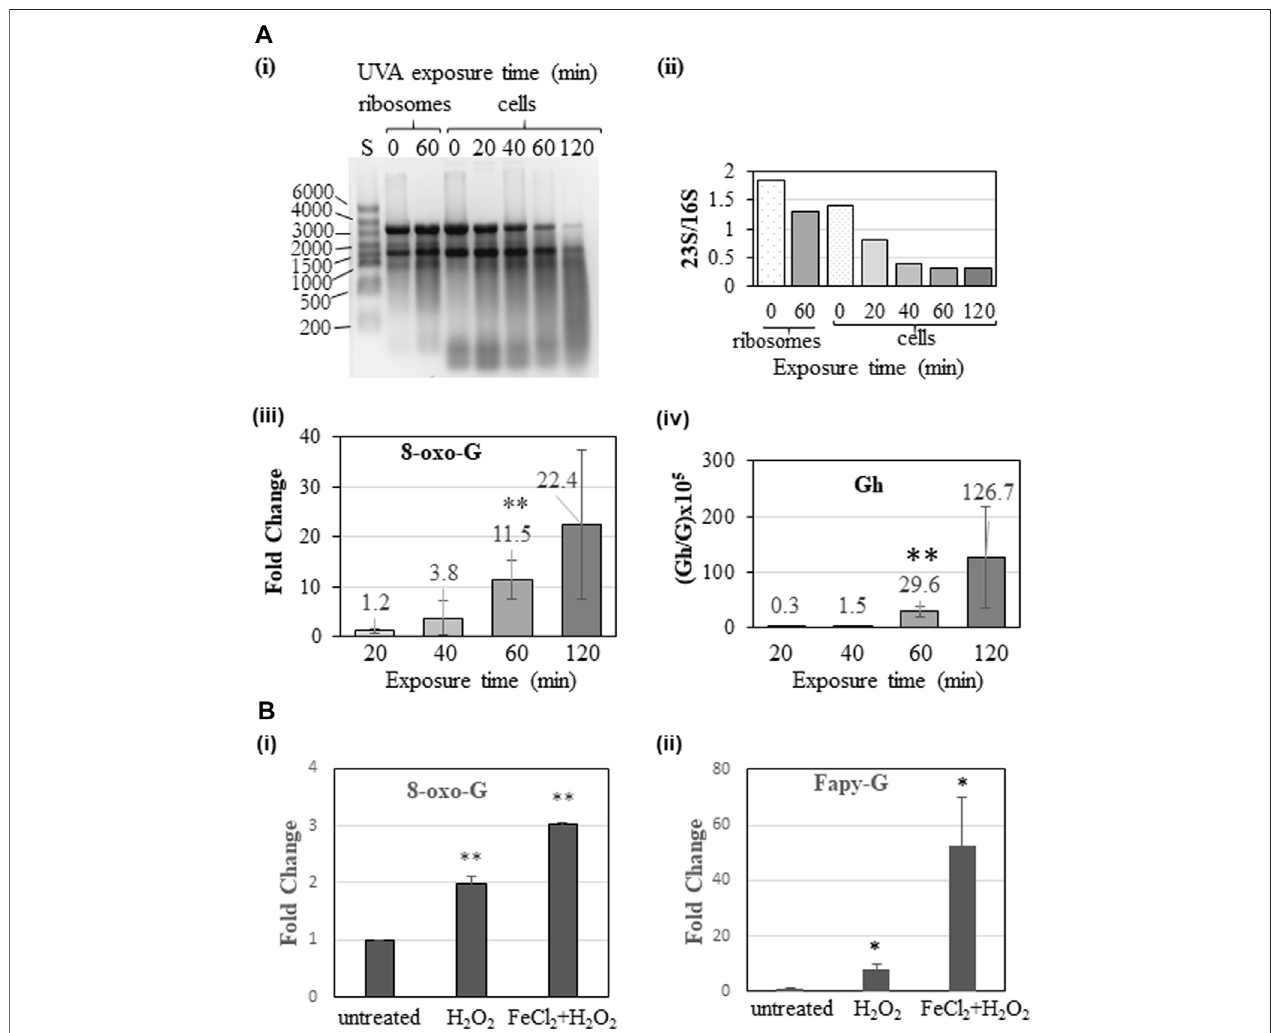
FIGURE3 | Effectsofoxidativestresson rRNA upon cellular exposure. (A) UVA-induced oxidationand fragmentation ofribosomal RNA in E. coli cells. Ribosomes or mid-log phase ( ∼ 0.5 OD600) E. coli cell culture was exposed to UVA and fractionated ribosomal RNA was analyzed. (i) Gel electrophoretic analysis of ribosomal RNA (2 µg each). Lane S-size standards, number ofnucleotides for each size standard RNA is denoted on left side. The lanes adjacent to the size standards contained rRNA isolatedfrom ribosome following 0(unexposed) and60 minofexposure. Remaininglanes depict therRNAisolatedfrom unexposed (0)andexposedcells after 20, 40, 60, and 120 min ofUVA exposure. (ii) Changes in levels ofrRNA asmeasured bythe ratio of respective signals.Elevated oxidation ofguanosines as8-oxo-G (iii) and Gh (iv) in rRNA with an increased UVA exposure are shown. (B) Fenton reaction induced oxidation in E. coli rRNA. E. coli cells at mid-log phase were treated with water (untreated) or 20 mM H 2 O 2 or 10 µM FeCl 2 and 20 mM H 2 O 2 for 30 min and RNA extracted and analyzed. Elevated oxidation products of guanosine as 8-oxo-G (i) and FapyG (ii) are shown. Statistical signi fi cance was computed using unpaired two-tailed t-test (** p < 0.01, * p <